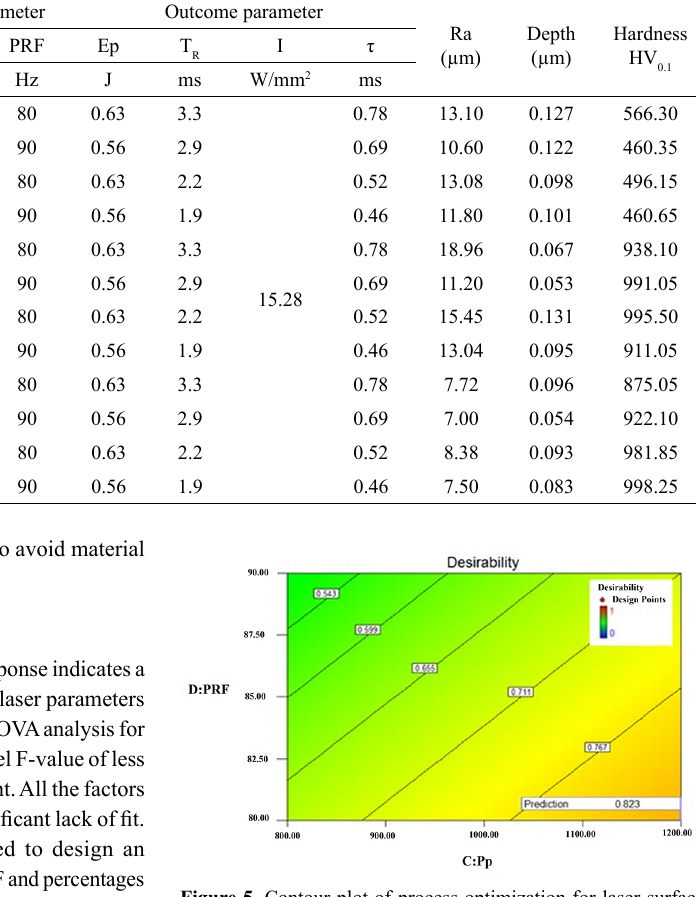
Figure 5. Contour plot of process optimization for laser surface cladding of grey cast iron at 1 mm laser spot